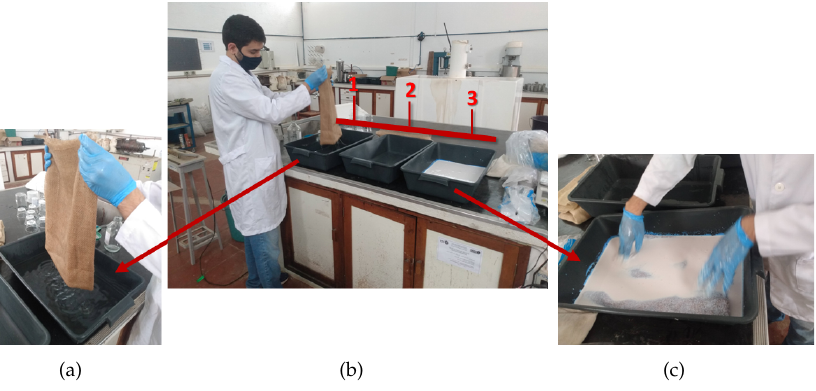
Figure 2. Treatment of jute fabric: ( a ) immersion in liquid PCM, ( b ) removal of PCM excess, and ( c ) coating by immersion in XSBR